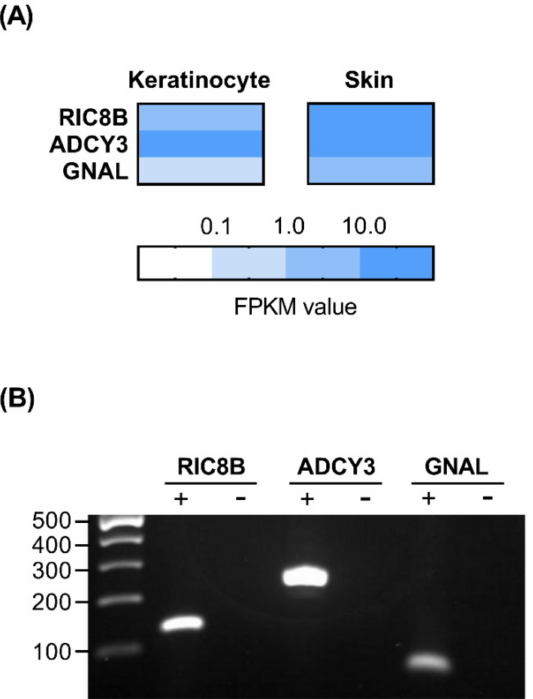
Figure 3. Presence of olfactory signaling pathway components in HaCaT cells. ( A ) Next-generation sequencing data of HaCaT cells and human skin tissues from the genotype-tissue expression (GTEx) database revealed the presence of three olfactory signaling pathway components genes, including Ric8b , adenylate cyclase type 3 ( ADCY3) , and G Protein Subunit Alpha L ( GNAL) . Dark blue represents high transcript expression, and white indicates low to no detectable transcript expression. ( B ) Reverse transcription polymerase chain reaction (RT-PCR) for Ric8b , ADCY3 , and GNAL verification in HaCaT cells. The mRNA samples converted into cDNA are shown as (+), and the negative controls containing mRNA are shown as (-). Numbers, length of fragments